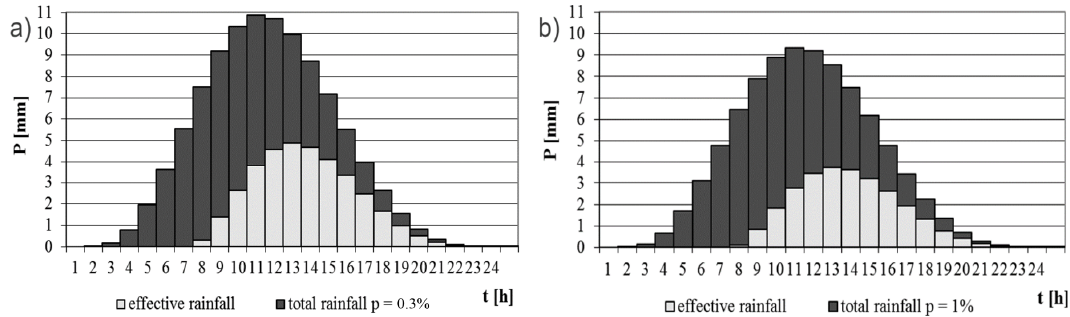
Figure 2. Land use classes of the Łęgoń catchment according to the CORINE Land Cover Map.